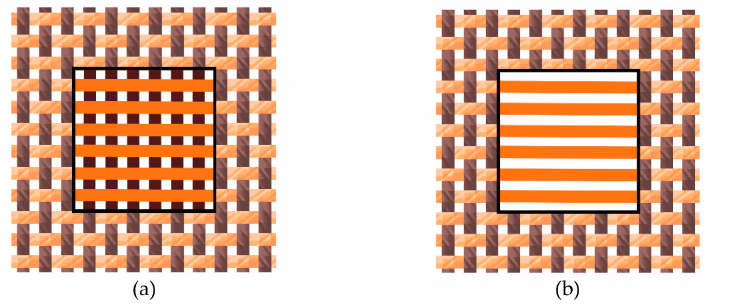
Figure 4. Preparation of thread system samples for measurements: ( a ) woven fabrics with floating warp and weft yarns; ( b ) Removing the warp and display measuring surface of thread distribution—thread system sample.